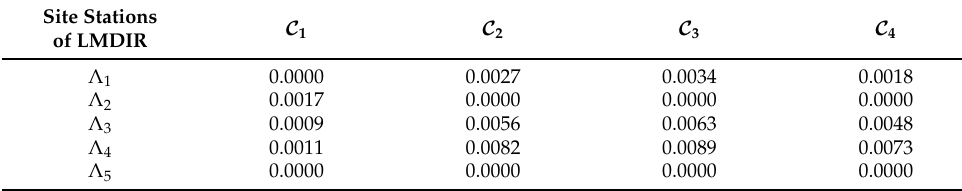
Table 7. Negative distance